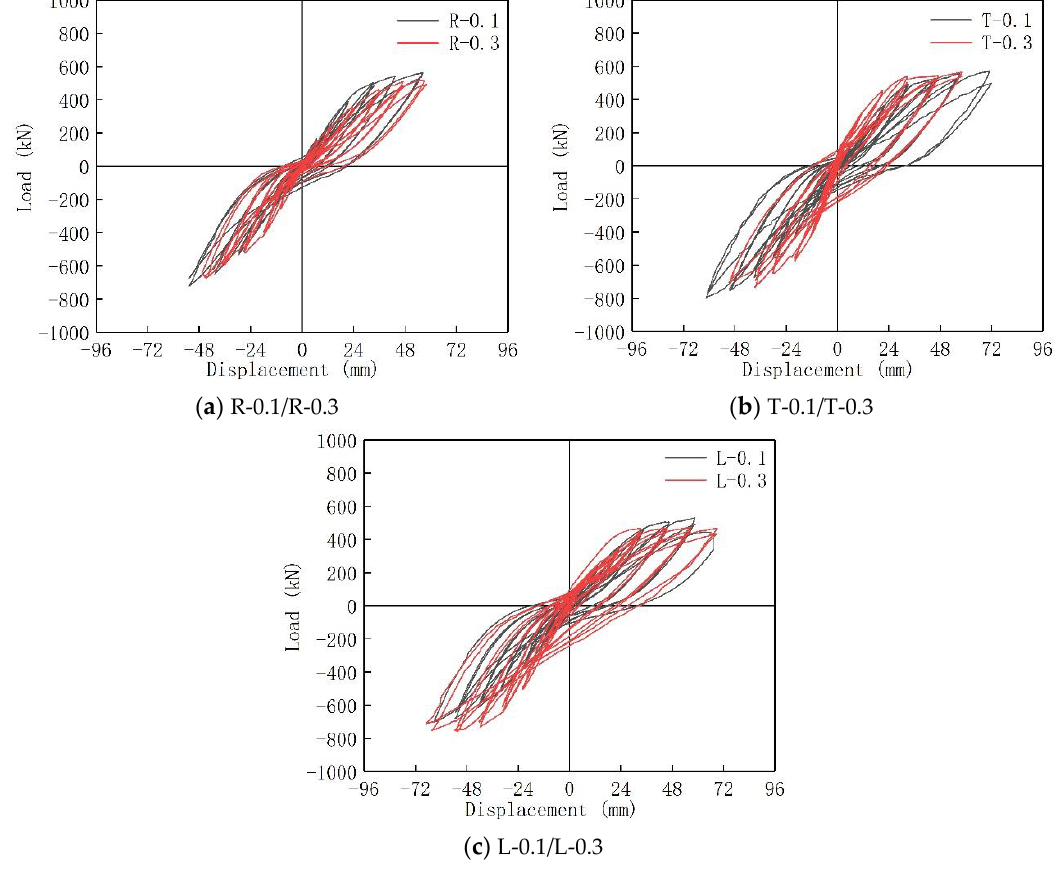
Figure 12. Hysteretic